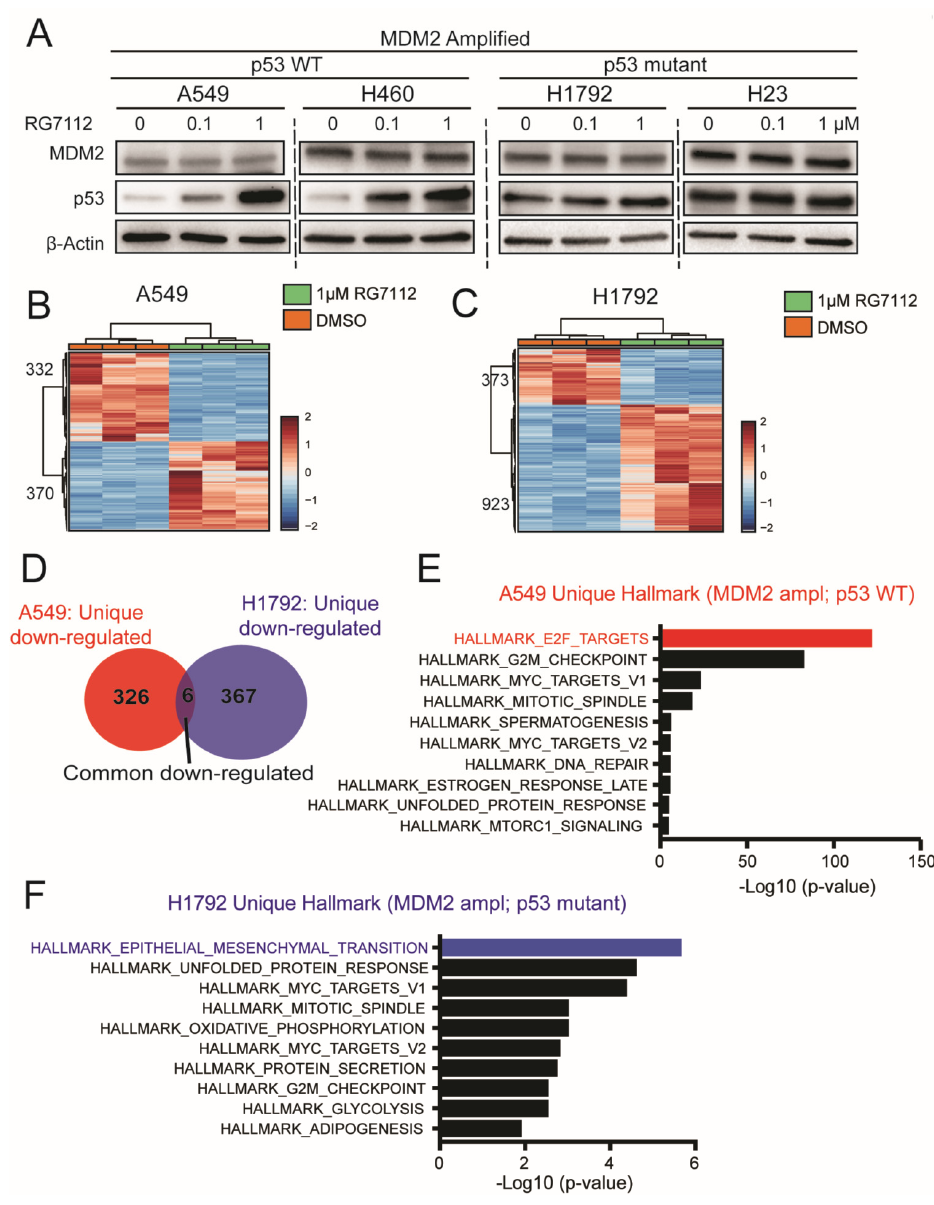
Figure 5. MDM2 inhibitor alters unique signaling in MDM2 amplified; p53 mutant vs. WT back- ground. ( A ) Western blot for MDM2, p53 and β -actin in A549, H460 (MDM2 ampl; p53 WT) and H1792, H23 (MDM2 ampl; p53 mutant) treated with DMSO, 0.1 µ M RG7112 or 1 µ M RG7112 for 48 h. ( B , C ) Heatmap showing DEGs with log2 fold change greater or less than 1 and FDR < 0.05 ( B ) A549 (MDM2 ampl; p53 WT) and ( C ) H1792 (MDM2 ampl; p53 mutant) treated with DMSO or 1 µ M RG7112 for 48 h. ( D ) Venn diagram showing unique and overlapping differentially